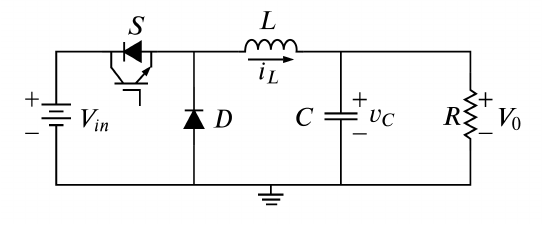
Figure 1. Electrical circuit of a Buck converter.